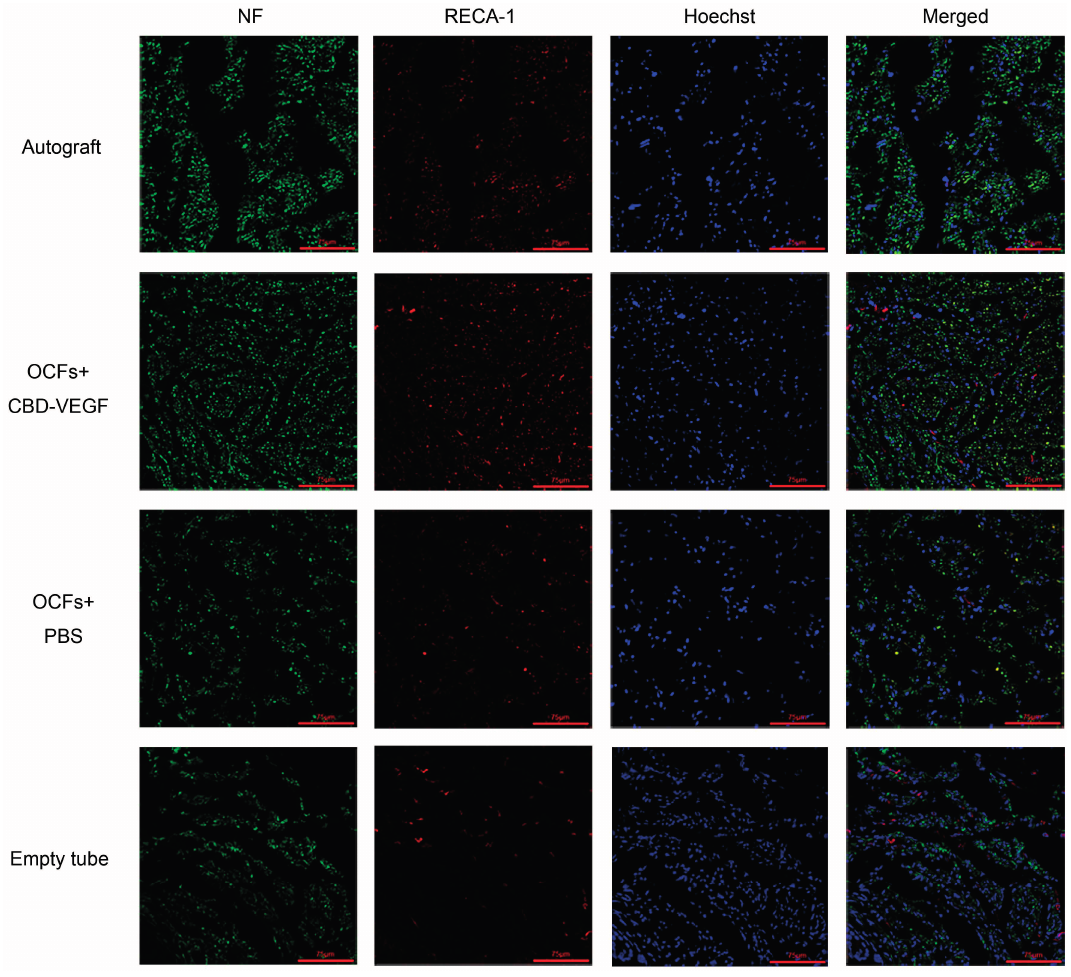
Figure 5. Confocal fluorescent images of transverse sections with anti-NF antibody (green) and anti-RECA-1 antibody (red) at week 12 following implantation for the four groups. Cell nuclei were counterstained with Hoechst dye (blue). Scale bar, 75